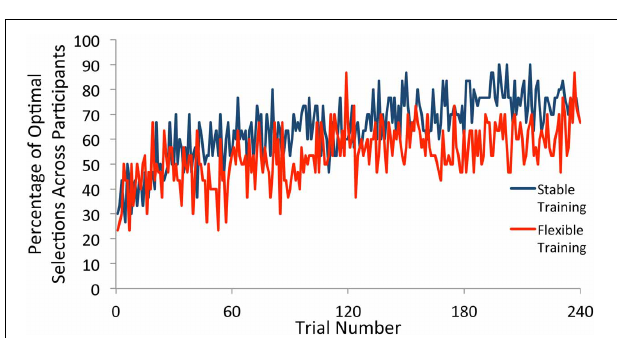
FIGURE 3 | Percentage of participants who selected the optimal square on each trial of the test phase. Participants selected the optimal target at a greater rate than would be expected due to random guessing throughout the test phase following both stable and flexible